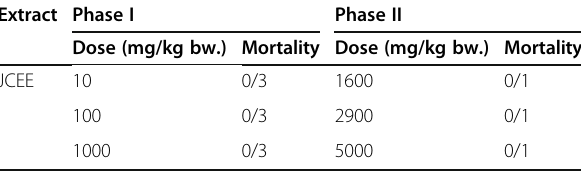
Table 1 Acute oral toxicity of ethanol extracts of J. carnea Extract Phase I Phase II